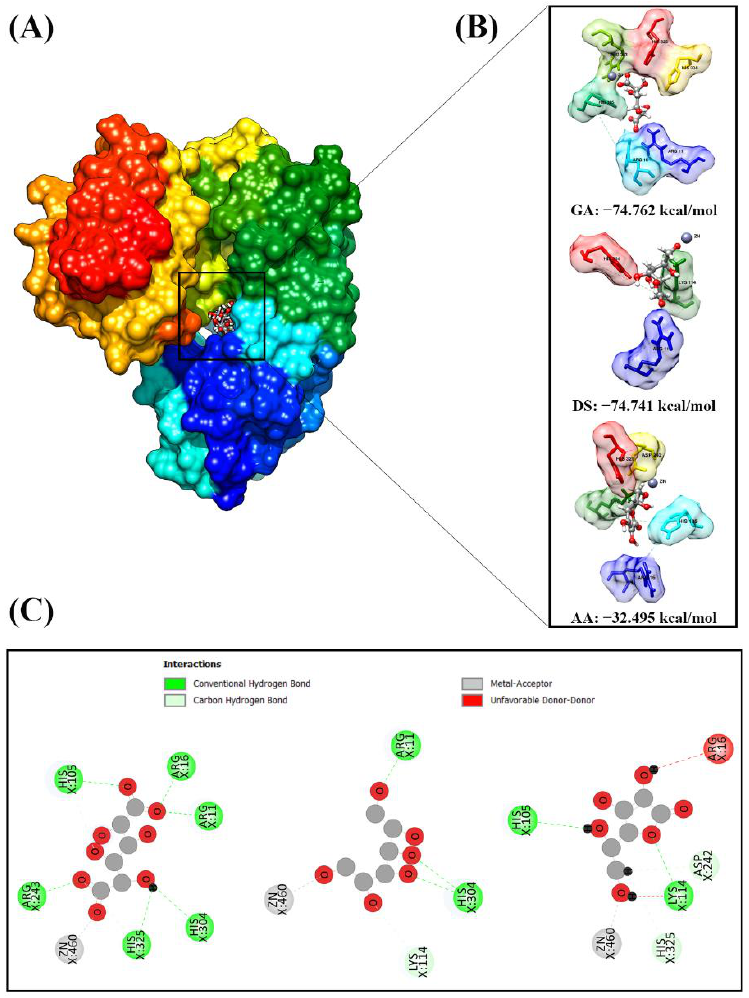
Figure 4. Phosphomanomutase/phosphoglucomutase (PMM/PGM) molecular docking: ( A ) docking of ligands on the PMM/PGM active site based on the L-tartaric acid (TLA) ligand coordinates as a reference, ( B ) conformation of ligands on the active site of PMM/PGM using the grid score function, and ( C ) the type of interaction shown in a two-dimensional diagram.